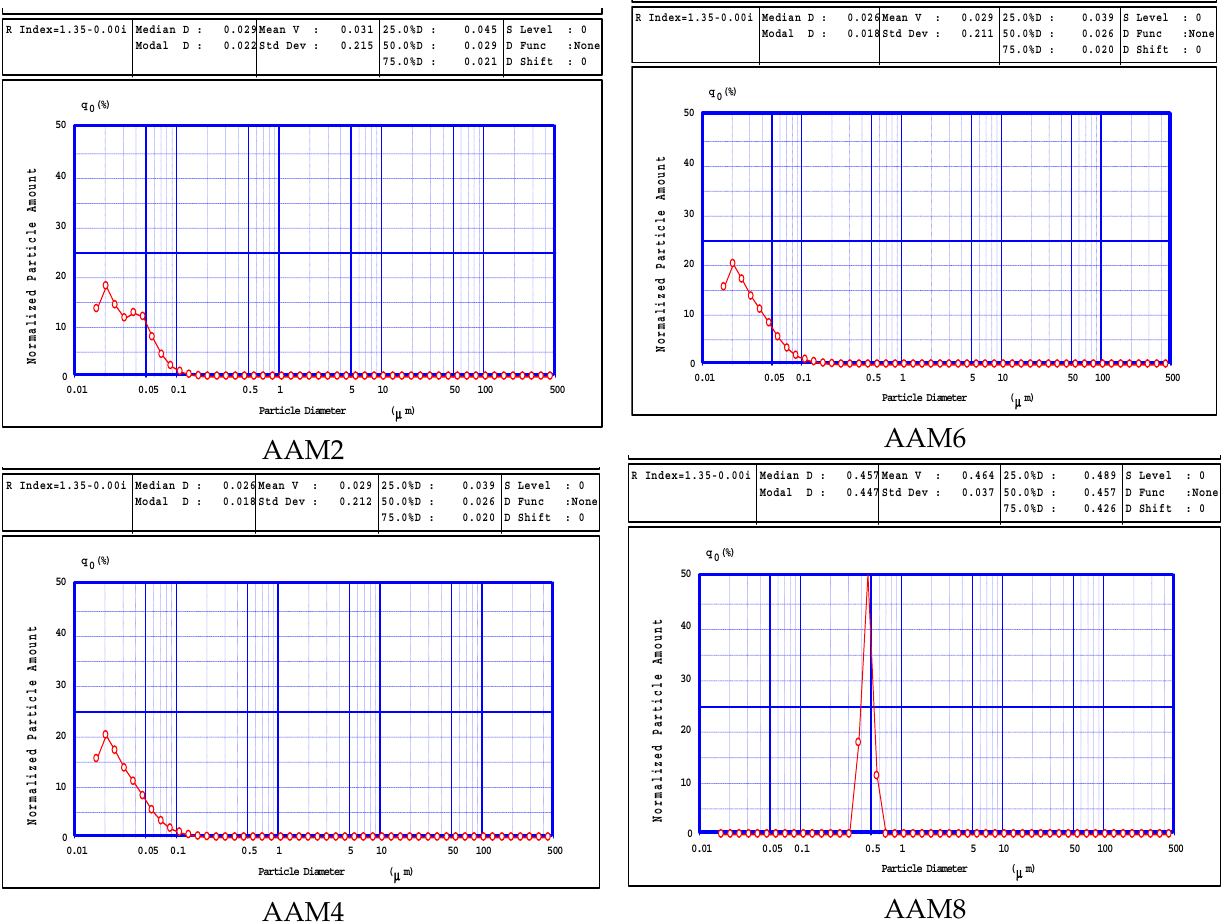
Figure 5. Particle size distribution of several samples. The particle size distribution for the samples AAM2, AAM4 and AAM6 are very similar to each other. The elementary particles detectable have diameters below 0.1 µ m and the distribution curve shape is asymmetric and wide. A characteristic median diameter of 0.026 µ m and modal diameter of 0.018 µ m can be defined for AAM4 and AAM 6 samples. The particle size distribution for sample AAM2 has a somehow similar shape, but the curve is rather irregular; the median diameter value deduced by the data processing of 0.029 µ m does not define a characteristic value as for samples AAM4 and AAM6. The results for sample AAM8 are dramatically different: the particle size distribution is described by a very narrow curve showing a median diameter of 0.457 µ m and the modal diameter of 0.447 µ m. The particle size distribution confirms the results obtained by SEM analysis, indicating that the smooth spheres seen by microscopy are really individual particles with very similar radius values. These particles result during the treatment in the presence of low volume of NaOH solution at 25 ◦ C only are formed just by the dissolution of the pseudo-matrix containing the spherical particles from the initial fly ash. The low temperature value and the diluted NaOH (8M) could not dissolve parts of the spheres included in the fly ash, as in the other samples. These deeper reactions required either a more energetic set of conditions (temperature of 65 ◦ C, AAM2 and AAM4) or a 3:1 liquid/solid ratio. The narrow particle size distribution encountered for sample AAM8, as shown by the results in Figure 5, indicate that the particles are bigger and have a very narrow particle distribution, as shown by the very close values of the median, modal and mean diameters